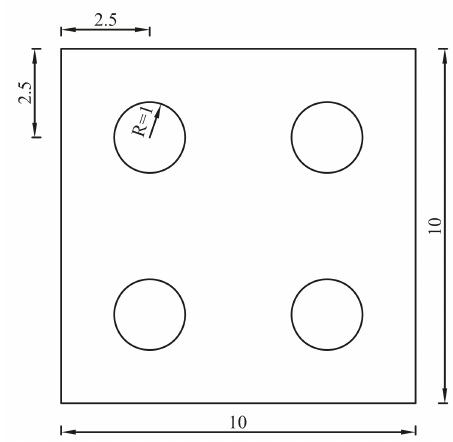
Figure 16. A plate with four